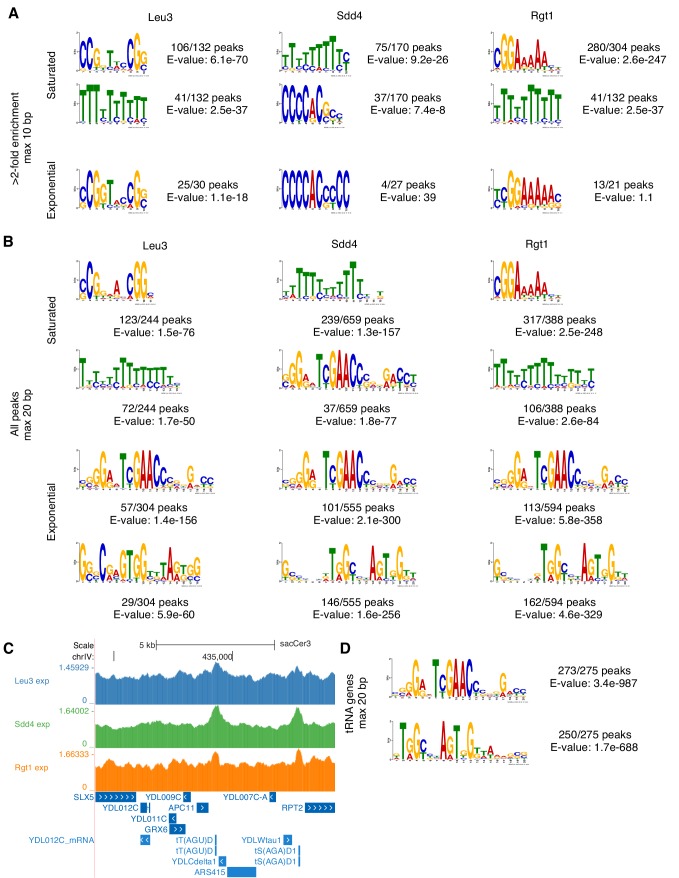
De novo motif discovery reveals ChIP-seq enrichment of known motifs, poly-T tracts enriched in promoters, and tRNA genes.(A) Expected TF motifs and poly(dA-dT) tracts, which are common in yeast promoters and activate transcription via their intrinsic nucleosome depletion (Iyer and Struhl, 1995; Struhl, 1985), are enriched in top ChIP-seq peaks. Motifs were discovered using MEME (E-value < 0.1, or top motif if none below threshold) (Bailey et al., 2006) on all ChIP-seq peaks with at least 2-fold enrichment, allowing motifs of up to 10 bp. Motifs are shown in the orientations that match known motifs. (B) Low-enrichment ChIP-seq peaks contain a long unexpected motif. As in panel A, motifs discovered using MEME (top two motifs) but on all ChIP-seq peaks, allowing motifs of up to 20 bp. (C) Low-enrichment ChIP-seq peaks at tRNA genes. Example of exponential growth ChIP-seq data at two tRNA gene loci. Coordinates (sacCer3 reference): chrIV:434220–434320. (D) tRNA genes contain motifs matching those from low-enrichment ChIP-seq peaks. Motifs discovered using MEME (top two motifs) on tRNA genes.